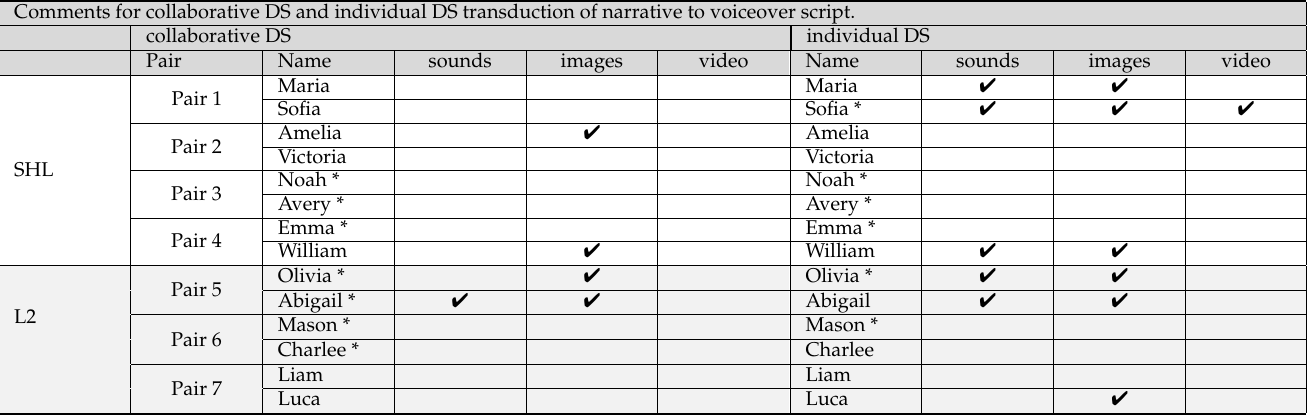
Table 7. Using images and sound to replace text in the individual simple narrative.